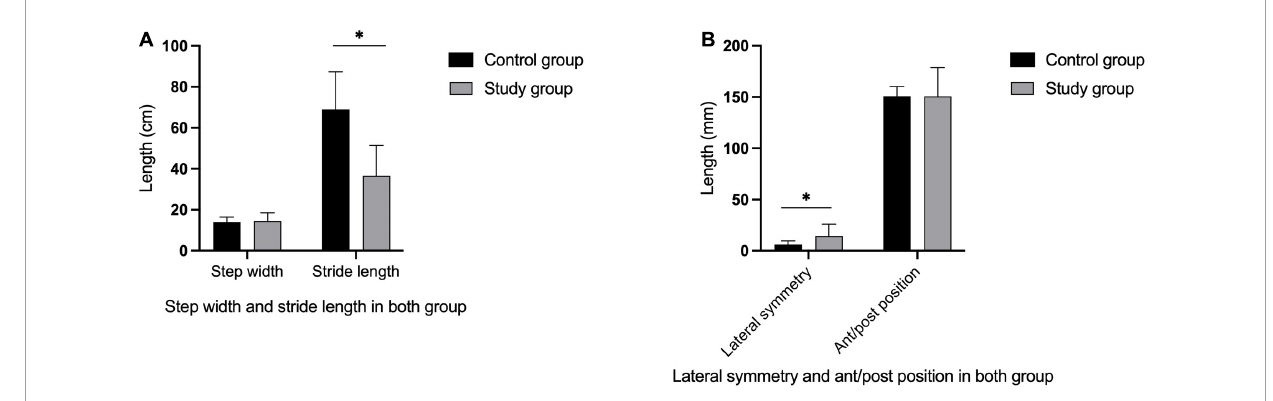
FIGURE3 Gait parameters in both group. The stride length in the study group was significantly lower than in the control group (A) ( P < 0.05), while there was no significant differences in step width between two groups (A) ( P > 0.05). The lateral symmetry in the study group were higher than in the control group (B) ( P < 0.05), while there was no significant differences in ant/post position between the two groups (B) ( P > 0.05). ∗ Indicates significantly different.